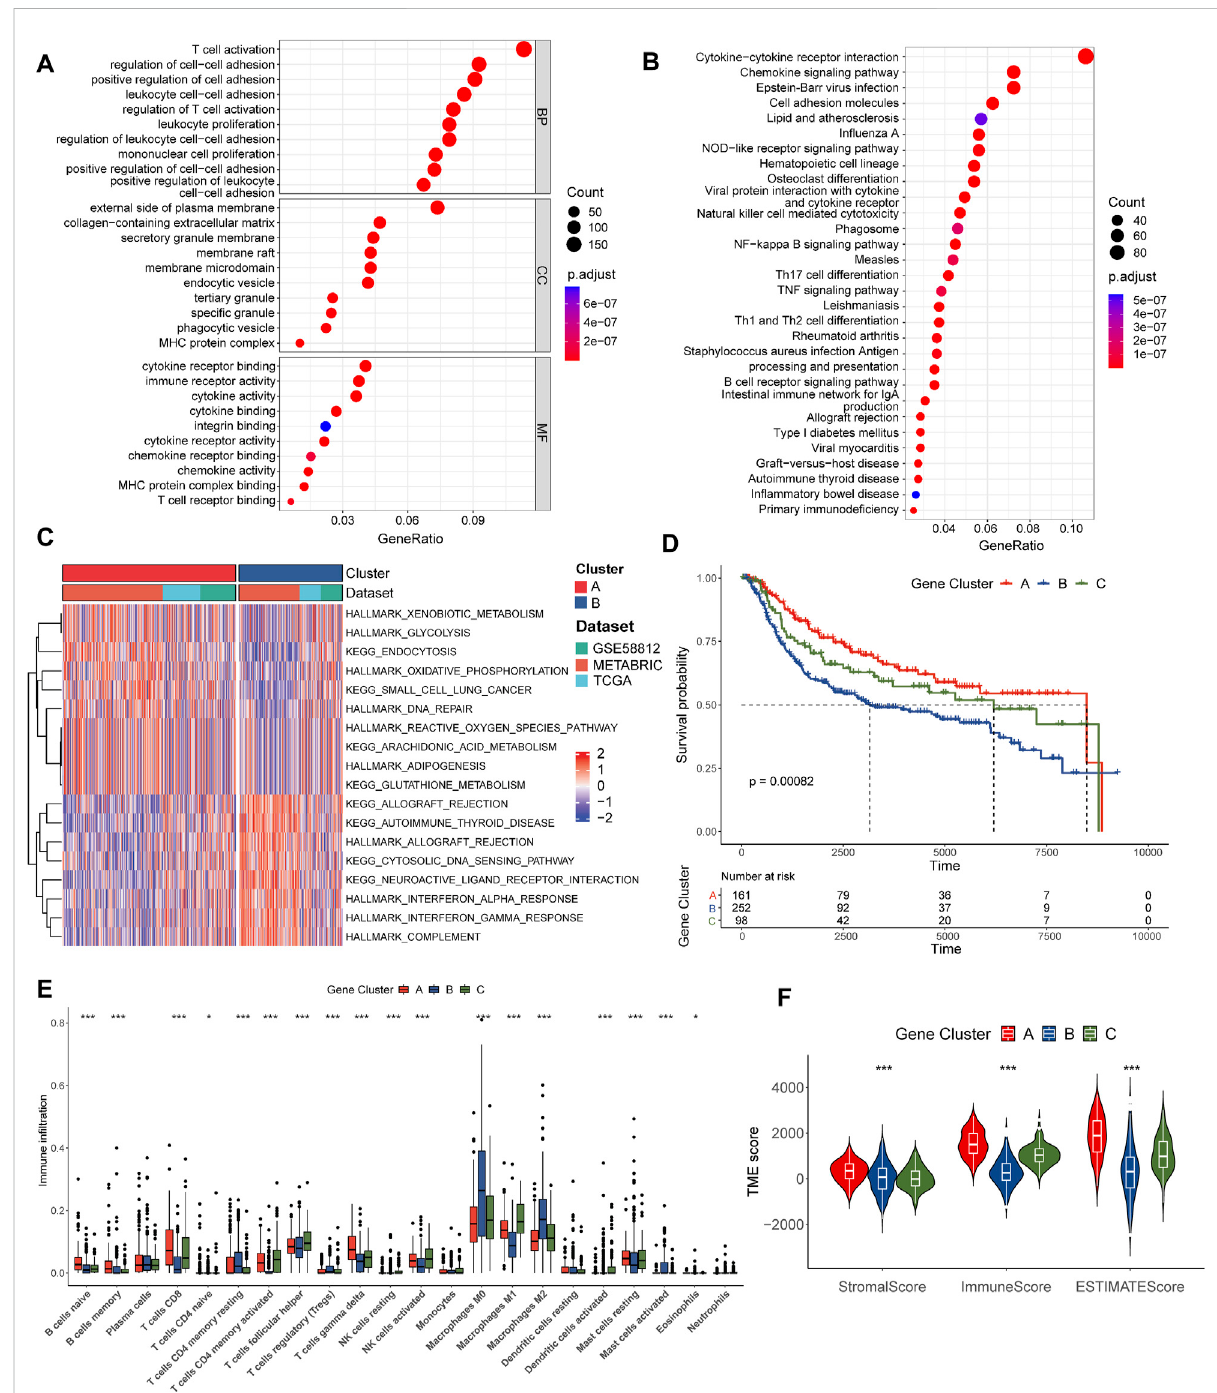
FIGURE 3 Identi fi cationofpyro-geneclustersbasedonDEGs. (A) GOenrichmentanalysesofDEGsbetweenthetwopyro-clusters. (B) KEGGenrichment analyses of DEGs between the two pyro-clusters. (C) GSVA of biological pathways between two pyro-clusters, in which red and blue represent activated and blue inhibited pathways, respectively. (D) Kaplan – Meier curves of OS for TNBC patients between three distinct pyro-gene clusters. (E) Abundanceof22in fi ltratingimmunecelltypesinthethreepyro-geneclusters. (F) Correlationsbetweenpyro-geneclustersandtheTMEscore. * p < 0.05, ** p < 0.01, *** p <